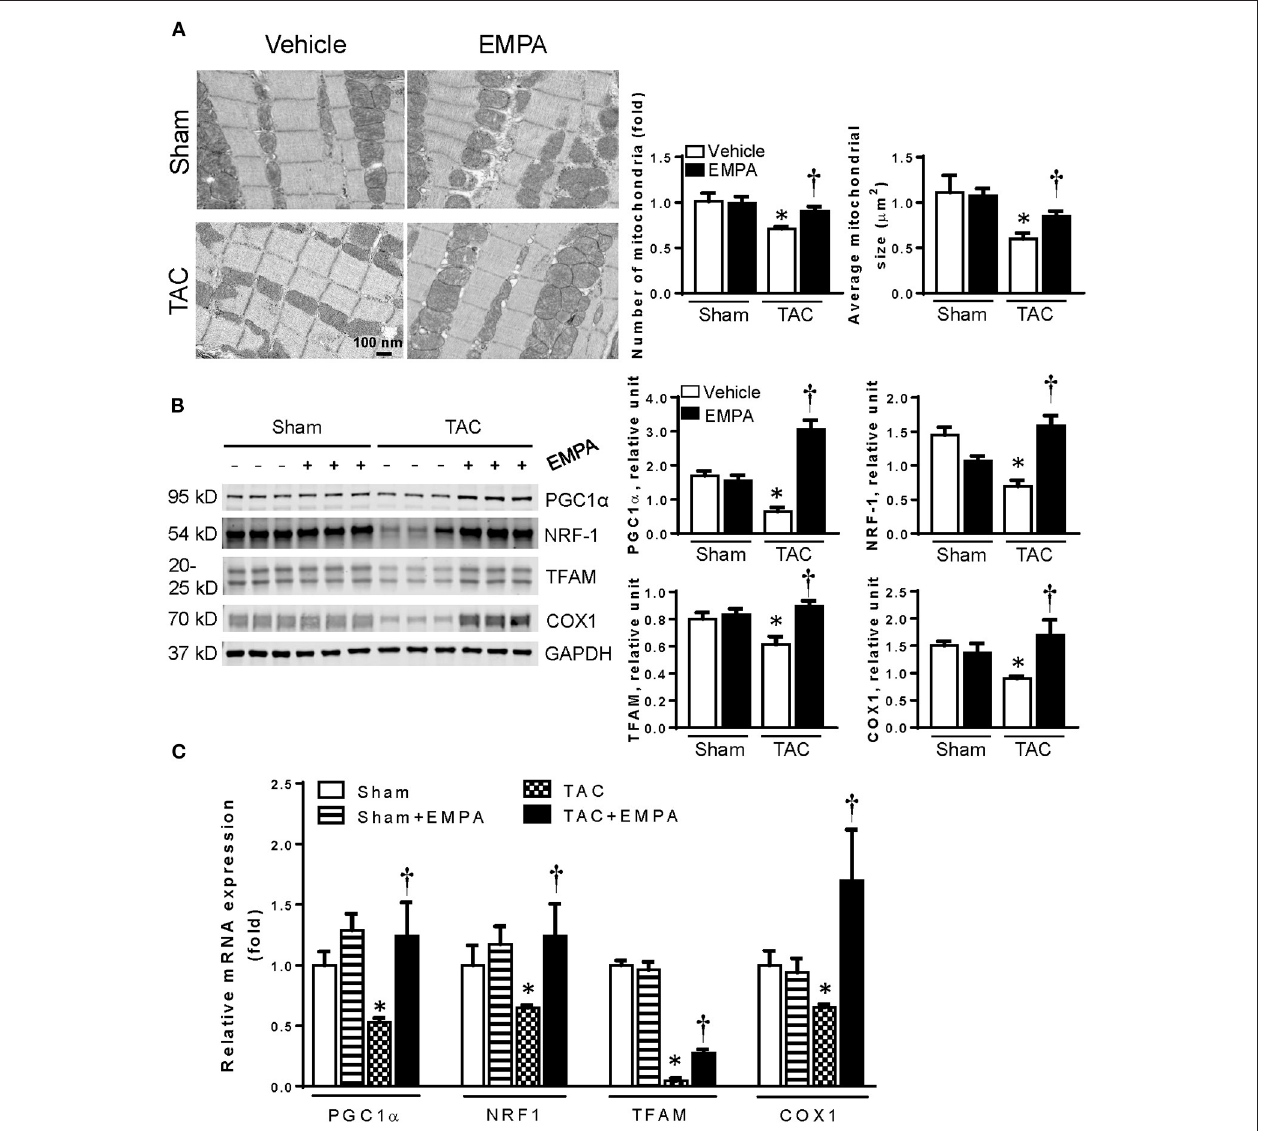
FIGURE 3 | EMPA treatment increased mitochondrial biogenesis. (A) Left, Transmission electron microscopy showing the morphology of mitochondria in sham, sham + EMPA, TAC and TAC + EMPA groups and Right, quantitative analysis of mitochondrial size and counts. Results are expressed as mean ± SEM, n = 3–5, * p < 0.05 vs. corresponding sham, † p < 0.05 vs. corresponding TAC. (B) Left, Representative blots of mitochondrial biogenesis-related proteins and Right, quantitative results. (C) Relative mRNA levels of PGC1 α , NRF1, TFAM and COX1. Results are expressed as mean ± SEM, n = 5–7, * p < 0.05 vs. corresponding sham group, † p < 0.05 vs. corresponding TAC vehicle group. One-way ANOVA and Tukey post hoc test. EMPA, empagliflozin; SEM, standard error of the mean; TAC, transverse aortic constriction; PGC1- α , peroxisome proliferator-activated receptor gamma coactivator 1-alpha; NRF-1, nuclear respiratory factor 1; TFAM, mitochondrial